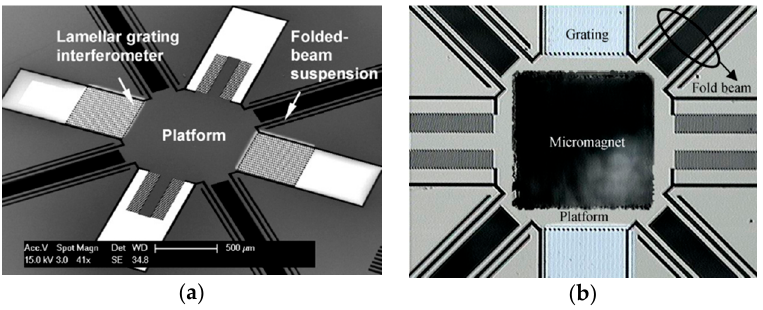
Figure 20. An electromagnetically driven Lamellar grating based FTS: ( a ) SEM; ( b ) microscope image. (Reprinted with permission from Reference [44] IOP Publishing, Ltd.).